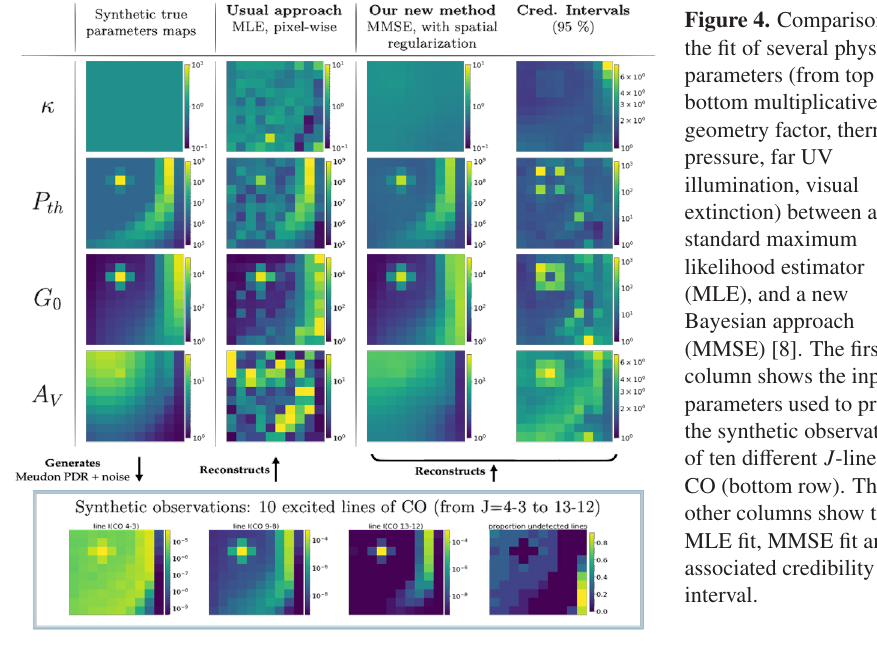
Figure 4. Comparison